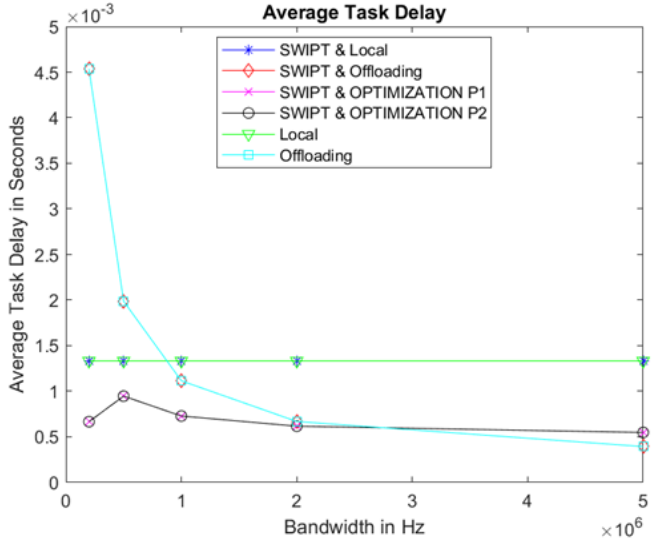
Figure 9. Average task delay of the end node.